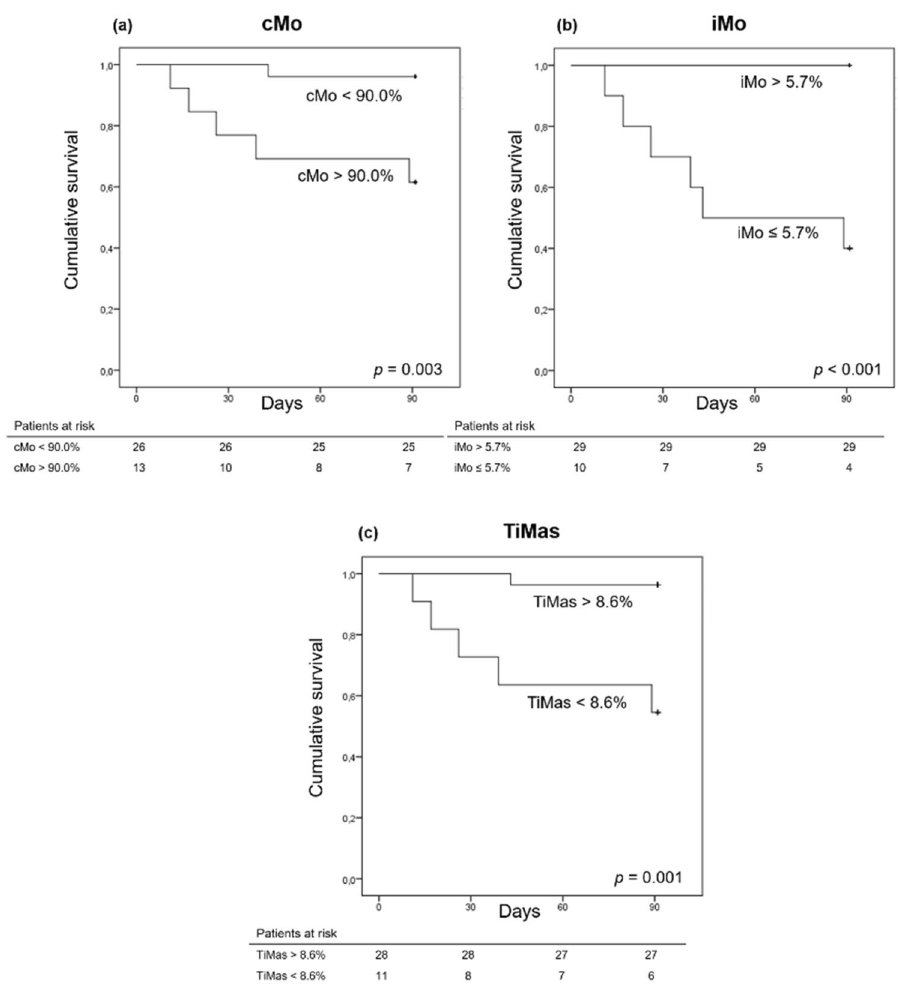
Figure 5. Cumulative 90-days survival of patients hospitalized with acute decompensation of cirrhosis according to monocyte subsets. The Kaplan–Meier survival probability was 96.2% in subjects with cMo frequencies < 90.0% and 61.5% in those with values > 90.0% ( p = 0.003) ( a ), 100% in subjects with iMo frequencies > 5.7% and 60% in those with values ≤ 5.7% ( p < 0.001) ( b ), and 96.4% in subjects with TiMas frequencies > 8.6% and 54.5% in those with values < 8.6% ( p = 0.001) ( c